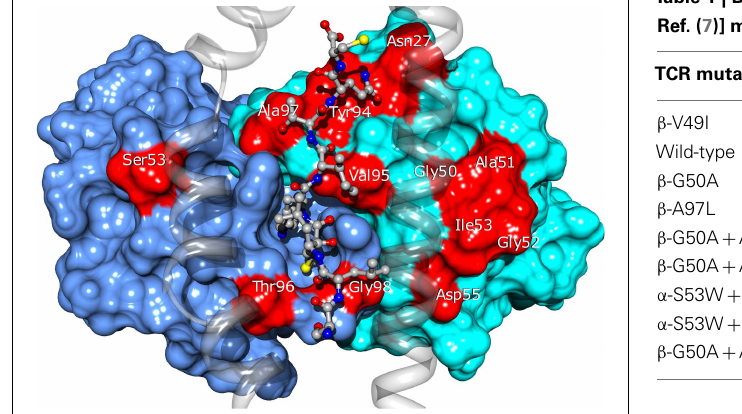
FIGURE 10 | Location of the BC1TCR residues for which sequence modifications were designed. TCR α and β are shown as blue and cyan surfaces. Modified residues are colored in red.The NY-ESO-1 peptide is shown in ball and stick and the MHC as a transparent ribbon. Only the α 1 and α 2 helices of MHC are displayed, for the clarity of the figure.